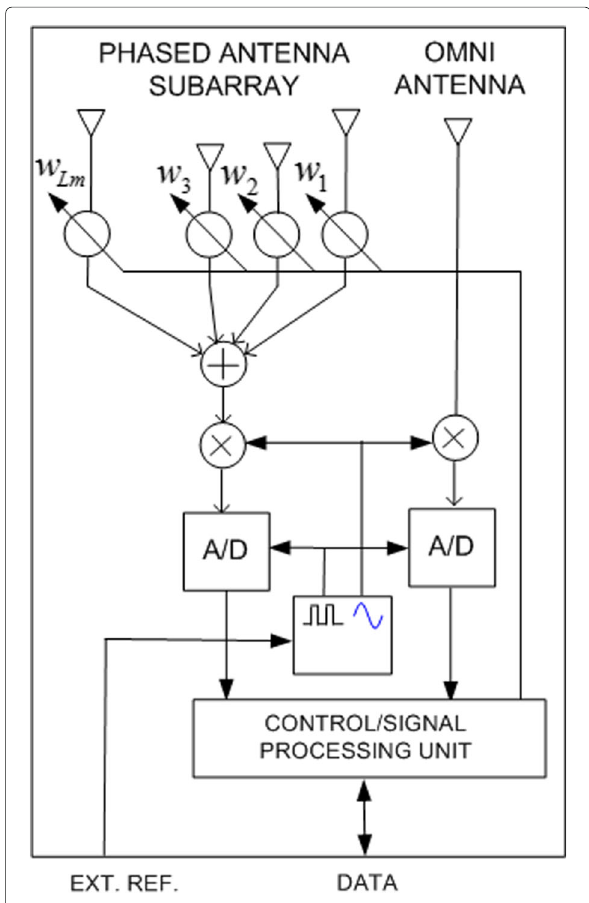
Fig. 2 A phased antenna subarray